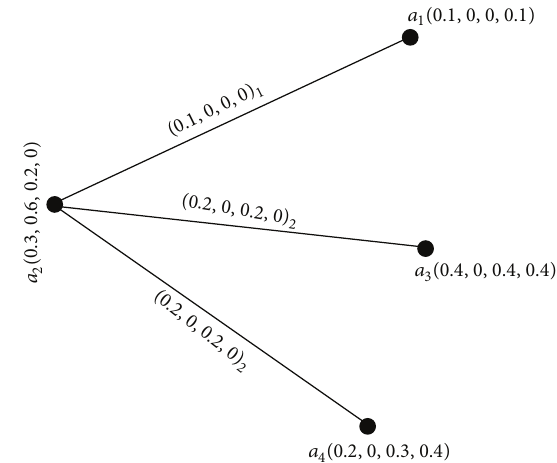
Figure 1: Four-polar fuzzy graph